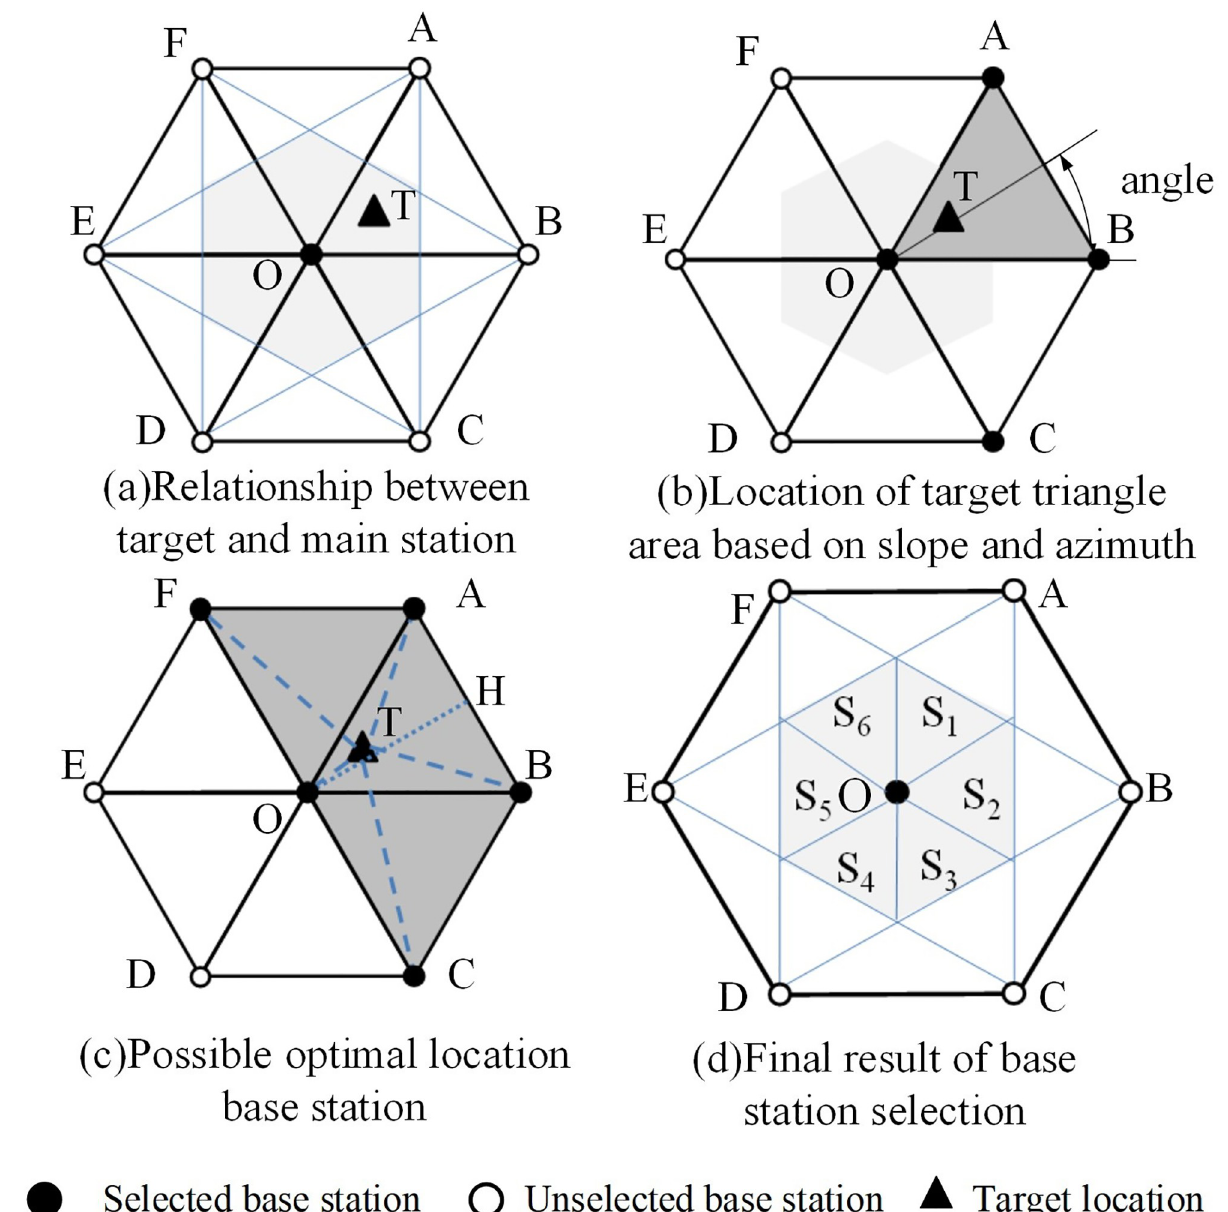
Fig 6. Base station selection based on nearest neighbor. (a) Relationship between target and main station, (b) Location of target triangle area based on slope and azimuth, (c) Possible optimal location base station, (d) Final result of base station selection. • Selected base station, � Unselected base station, ▲ Target